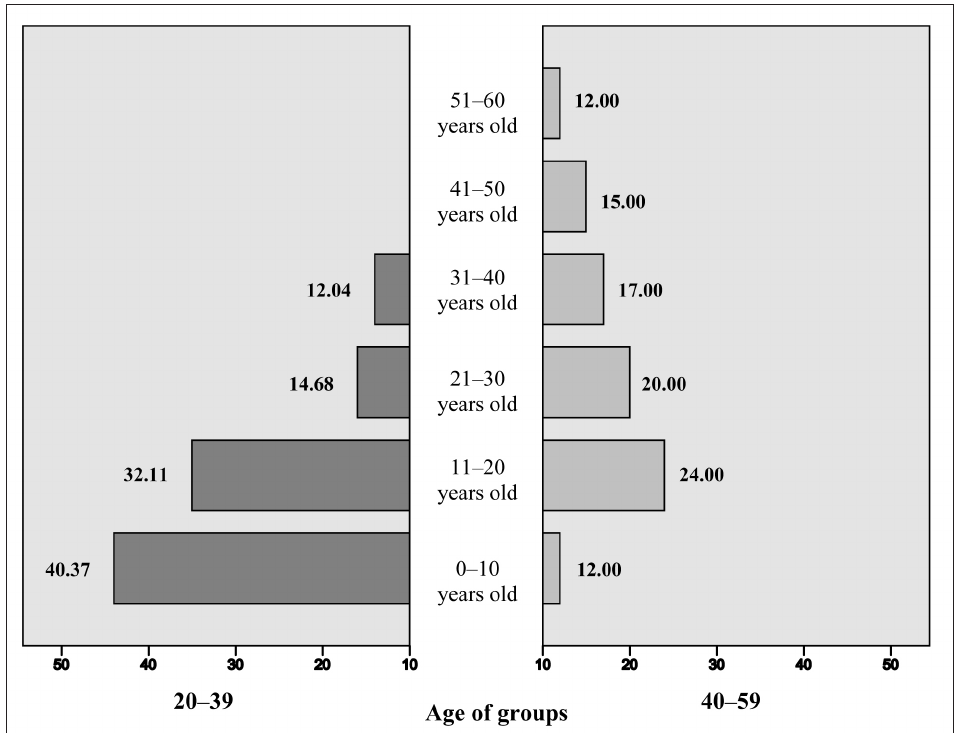
Figure 1. Patients with epilepsy grouped ac- cording to the onset of epilepsy